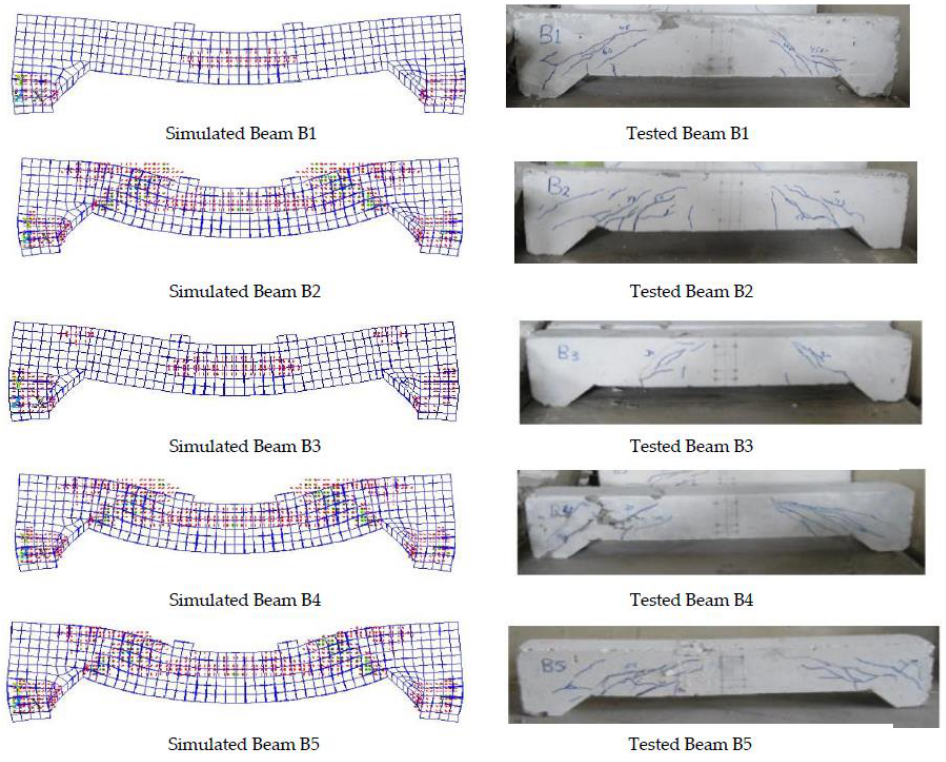
Figure 15. Cracking patterns and failure modes comparisons of the numerical simulated and tested RC beams [23].